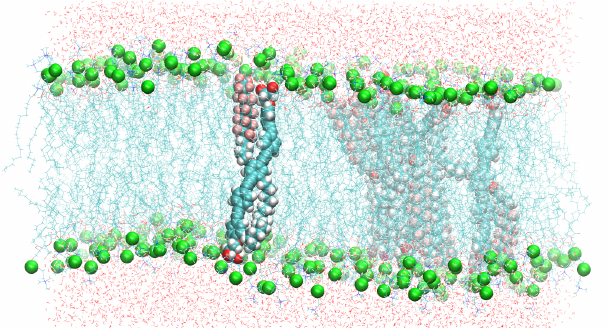
Figure 2. A snapshot of the simulated system containing six B16/10 molecules, 288 DPPC molecules and 8756 water molecules. Periodic boundary conditions were used in all directions. Atoms of B16/10 molecules and Phosphorus atoms of DPPC headgroups are represented by solid spheres. Phosphorus atoms are green, Fluorine atom of B16/10 side chains are pink, carbon atoms are cyan. All the lipid tails of DPPC are represented by cyan lines. One can see, that the backbone of the polyphile (cyan spheres) is bent and not